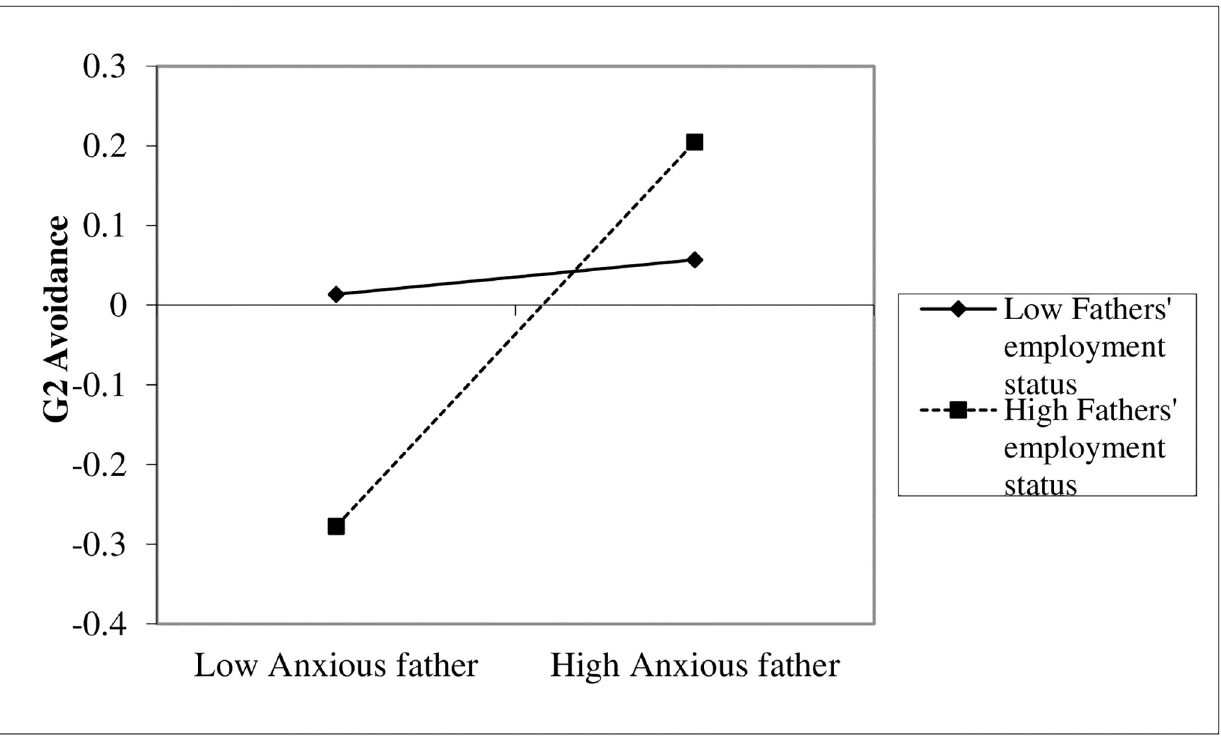
Fig 5. G1 fathers’ anxiety effects on G2 avoidance for low and high fathers’ employment status.